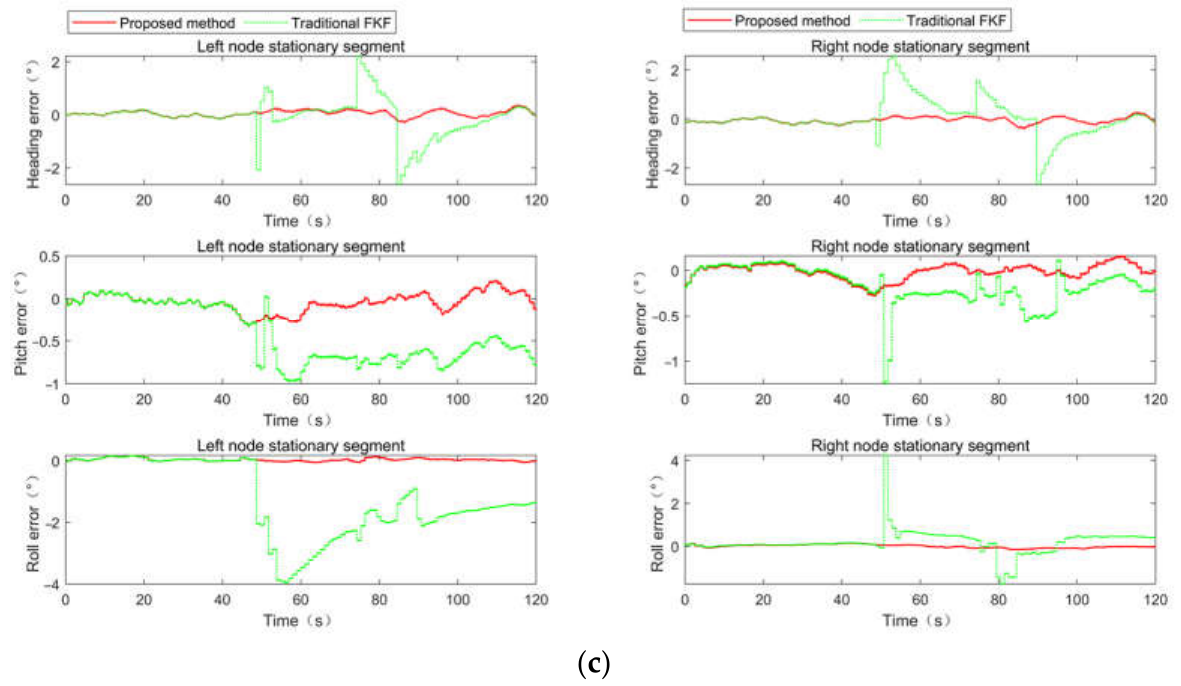
Figure 7. Comparison of filtering results. ( a ) Position comparison of filtering results; ( b ) velocity comparison of filtering results; ( c ) attitude comparison of filtering results.